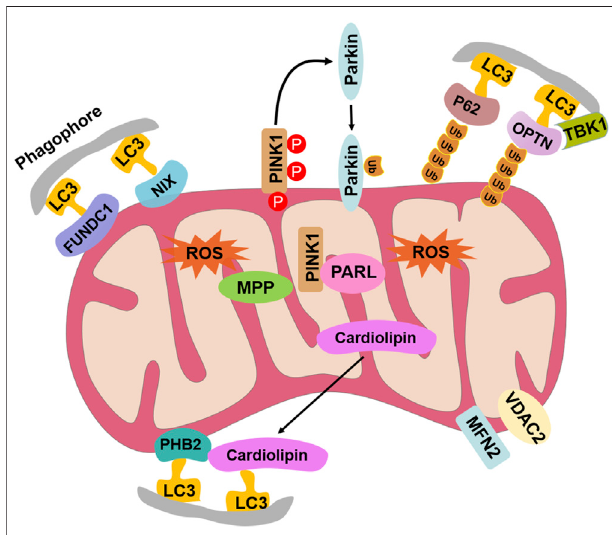
FIGURE8| MolecularmitophagypathwayofthePaci fi coyster, C.gigas